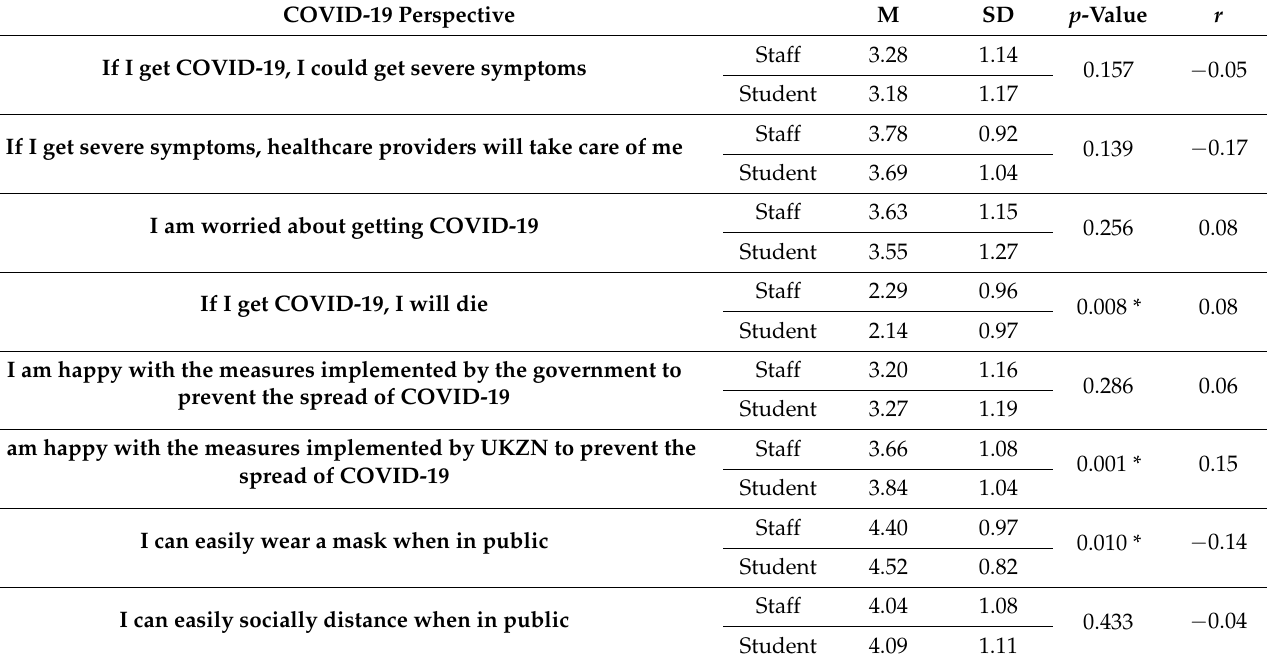
Table 4. COVID-19 perspectives.